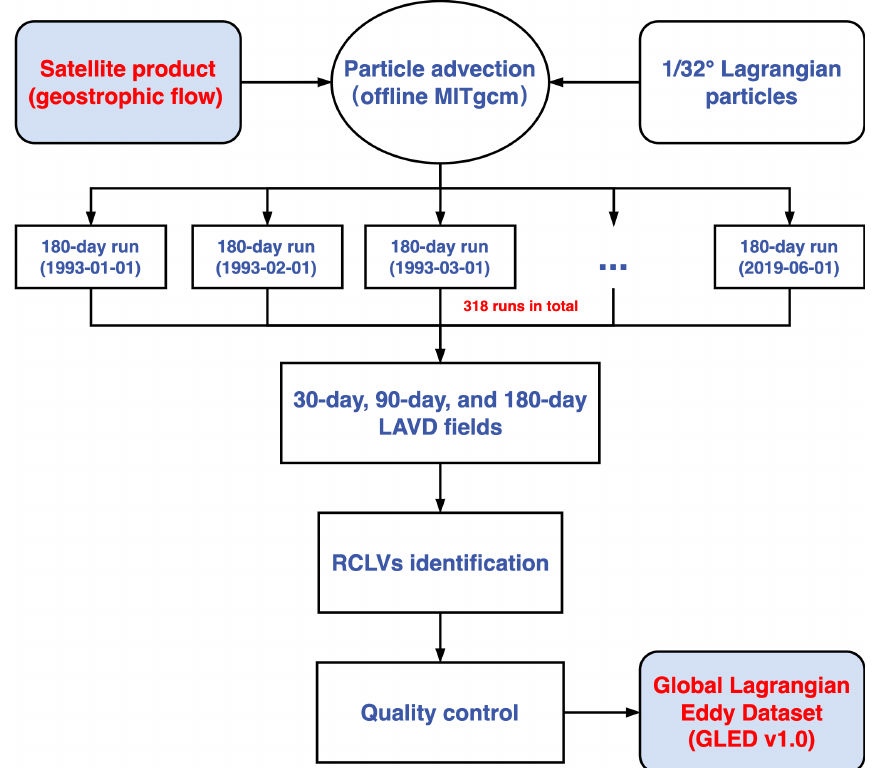
Figure 1. Flowchart of eddy dataset generation based on satellite